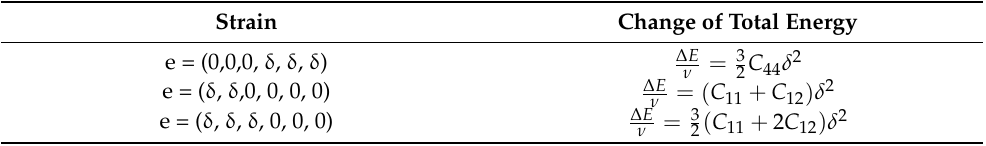
Table 1. Relationships between strain ( δ ) and total energy change ( ∆ E ) for a cubic crystal system. Strain Change of Total